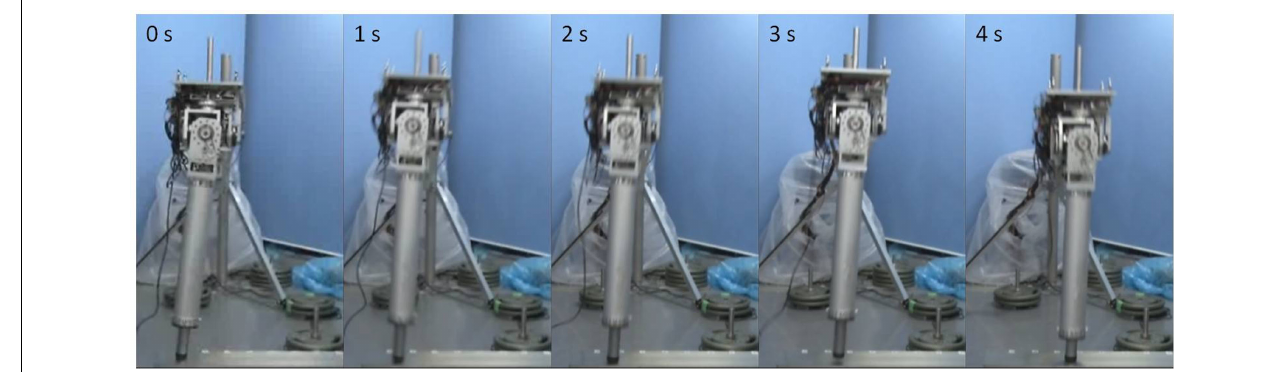
FIGURE 11 | Running experiment . The robot began its pelvic oscillation at 0s, and started to hop and run after a few oscillations at 1s. Then, the robot accelerated in forward direction by the foot placement control. In this experiment, the robot used only its pelvic motion for attaining jumping